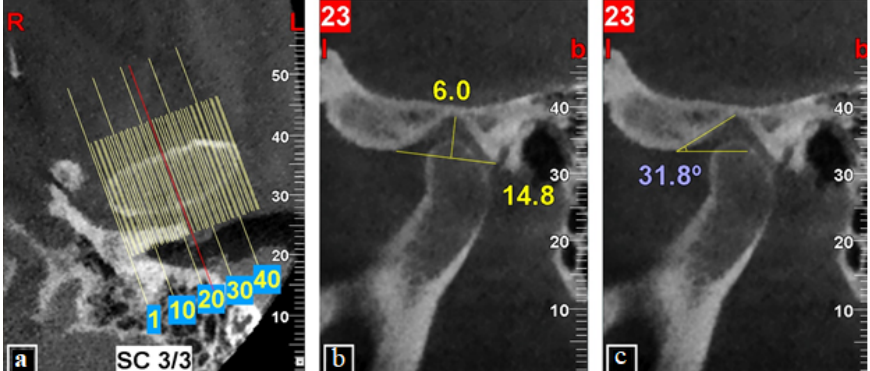
Figure 1. Axial view of the condylar process (a); linear measurements of depth and width of glenoid fossa (b); inclination of glenoid (c).